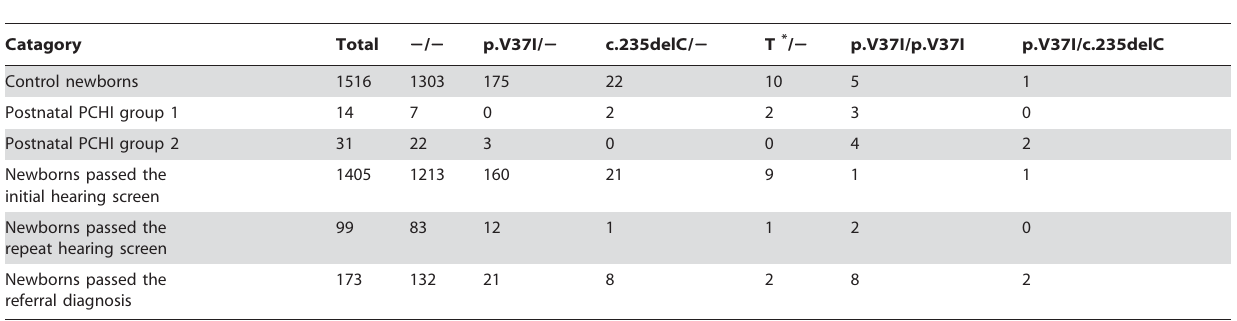
Table 1. Genotyping results of GJB2 in control and subject groups.